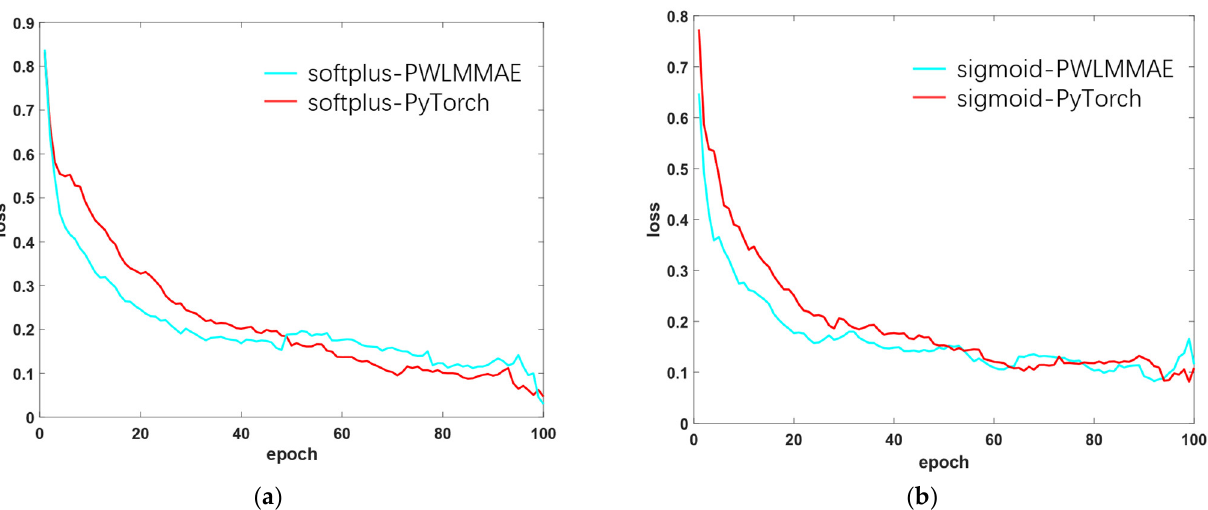
Figure 5. Comparison of the convergence speed of the activation function implemented using the PWLMMAE algorithm and the activation function encapsulated by PyTorch. (a) Comparison of the convergence speed of softplus. (b) Comparison of the convergence speed ofsigmoid.